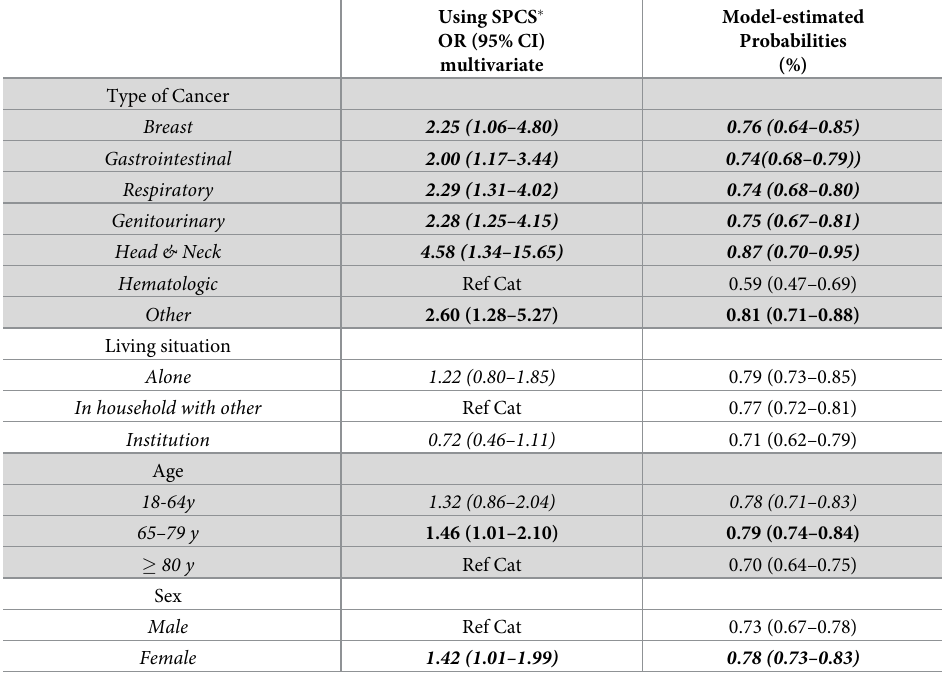
Table 3. Multivariabele odds ratios and probabilities for referral to specialist palliative care services, according to type of cancer and sociodemographic characteristics for all non-sudden cancer